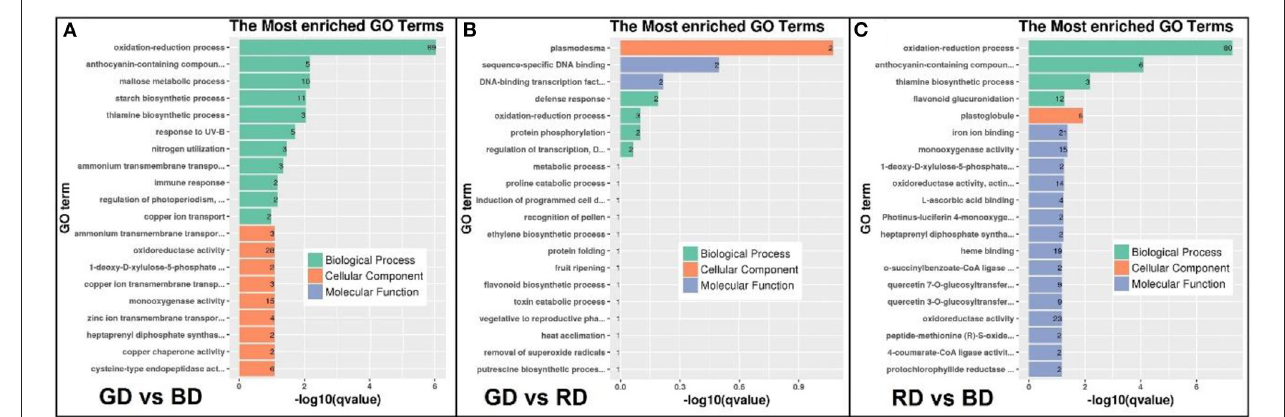
FIGURE 5 | The GO enrichment analysis of DEGs in the comparisons of GD vs. BD (A) , GD vs RD (B) , and RD vs. BD (C) in three main categories. BP, biological process; CC, cellular component; MF, molecular function.